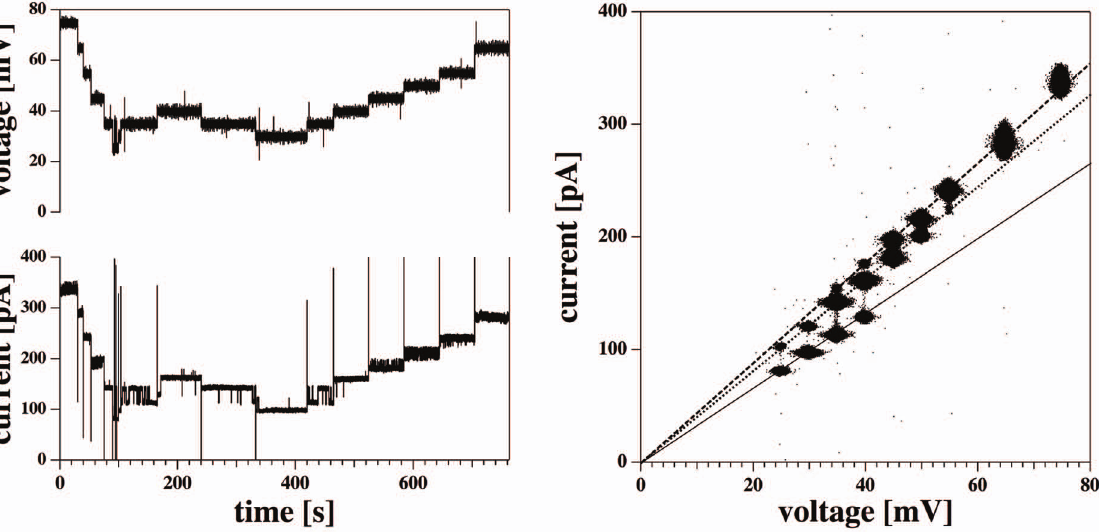
Figure 5. Recordings on a DMPC:DLPC membrane at 29 6 C. Top: Probability distribution for the first (left) and the second open state (right). Bottom: The calculated free energy difference for both conduction steps is consistent with similar quadratic voltage dependence (for parameters see text).